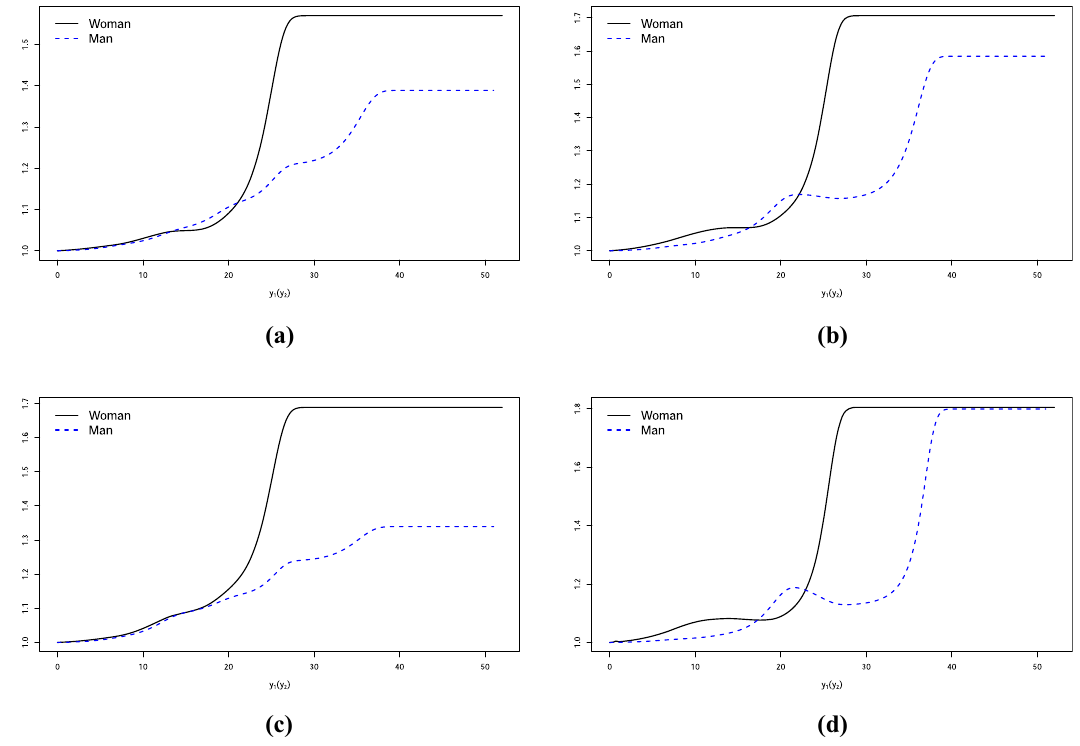
and ( ) x Ψ , 0 22 for the four couples. ( a ) Couple 1, ( b ) Couple 2, ( c ) Couple 3, and ( d ) Couple